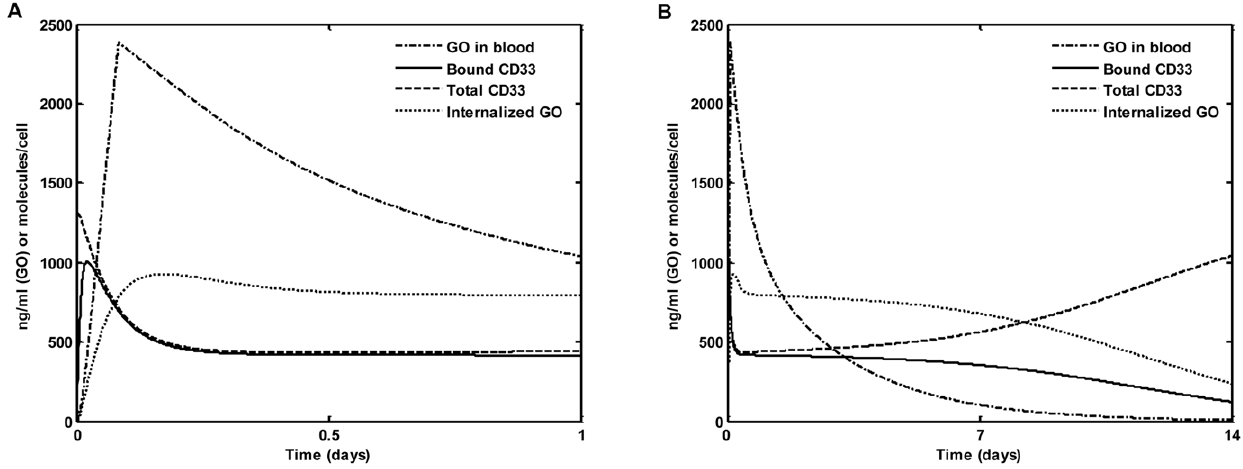
Figure 3. Simulation of the of CD33-drug interaction dynamics in patients. The mechanism-based PK model (4) was used to simulate dynamics of free, cell surface-bound and intracellular drug levels during and after 2-hour intravenous infusion. Model parameter values were set at population means (Table 1). The time series of each variable is depicted for short ( A ) and long ( B ) time period.